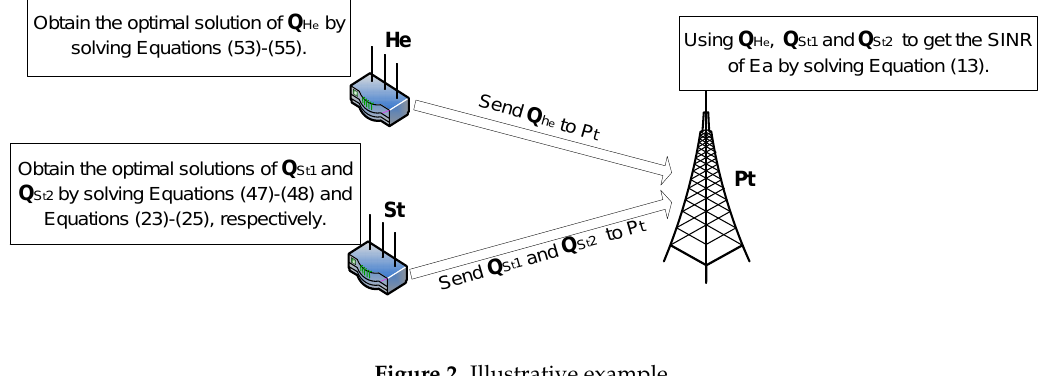
Figure 2. Illustrative